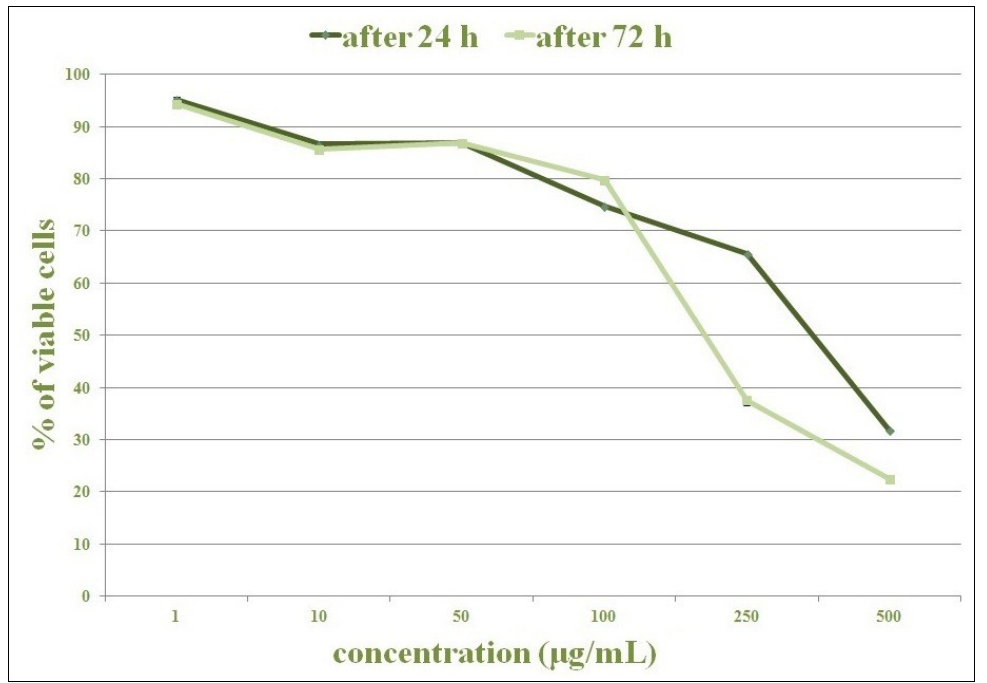
Figure 3. The cytotoxic effect of methanolic extract of O. vulgare on MDA-MB-231 cells, 24 and 72 h after exposure. The effect was measured by MTT cell viability assay. The data are mean ± SD of three independent experiments.